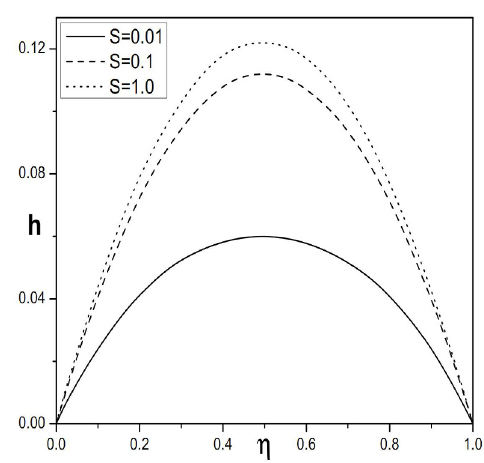
Figure 3. Effect of S on axial velocity at Re